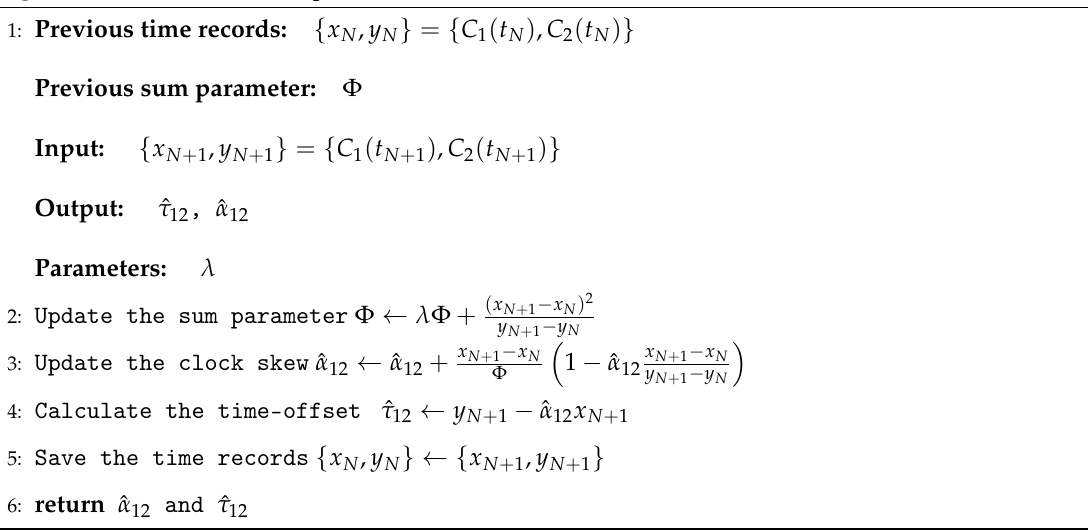
Algorithm 3 Recursive clock parameter estimator